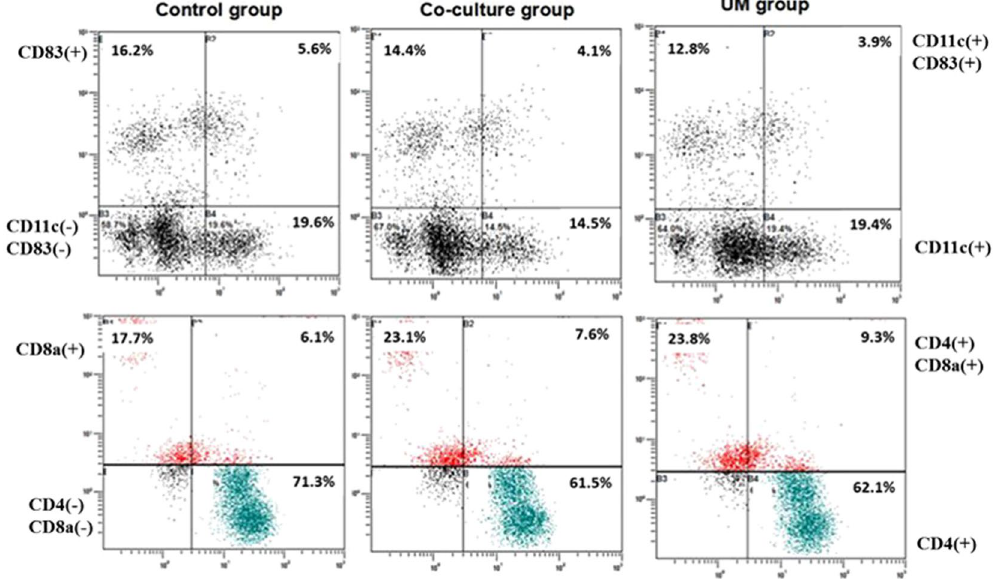
Figure 4. Flow cytometry detection of the phenotypes of immune cells in the control group, co-culture group and UM group after co-culture with RM-1 cells.